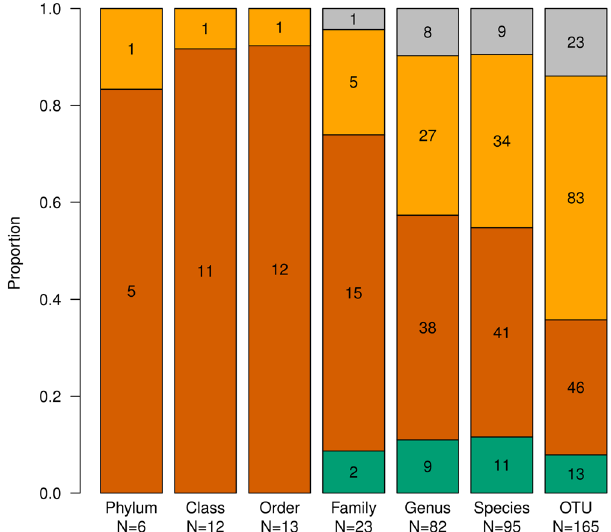
Figure 2. The proportion of taxa significantly affected by sampling or isolation kit at different taxonomical levels. Proportion of the tested taxa significantly affected by the sampling kit only (green), by the isolation kit only (dark yellow) and by both sampling and isolation kit (brick red). Grey indicates taxa not affected by sampling or isolation kit. The significance level was chosen at FDR < 10%, only taxa that met the selection criteria (maximum abundance > 1%) were